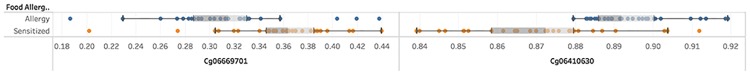
Distribution of methylation values for cg06410630 and cg06669701.